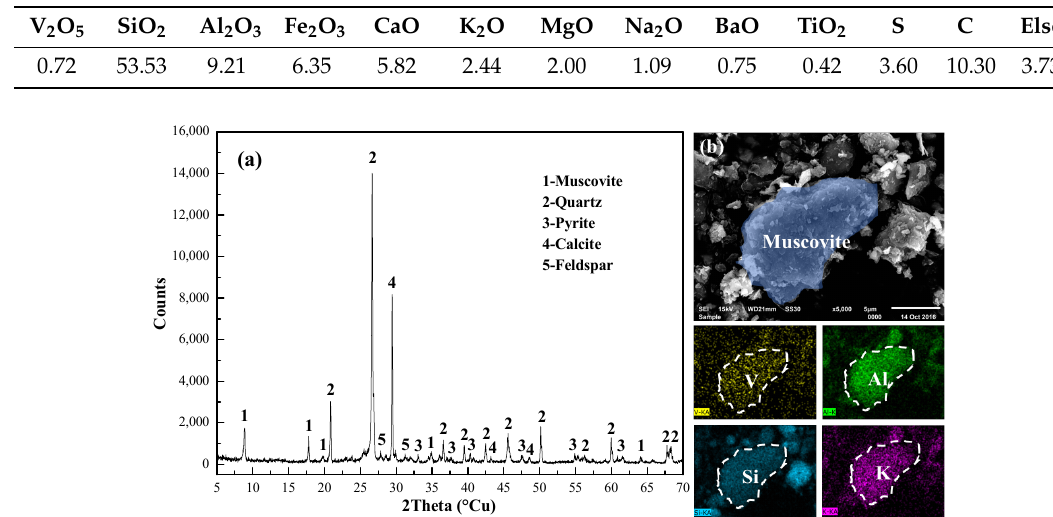
Table 1. Elemental compositions of the black shale (wt.%).